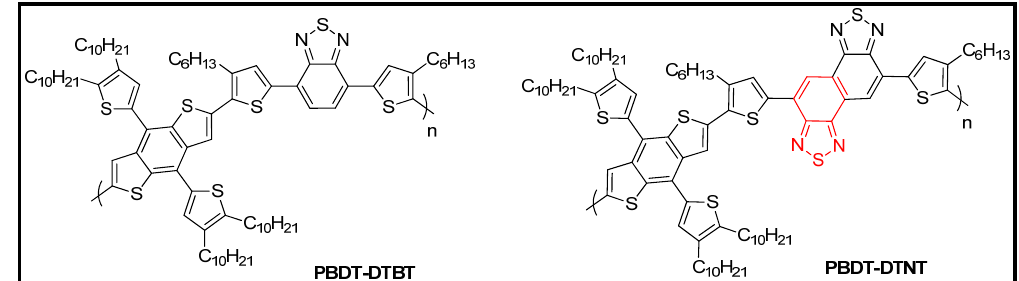
Figure 28. Molecular structure of PBDT-DTBT and its counterpart PBDT-DTNT.